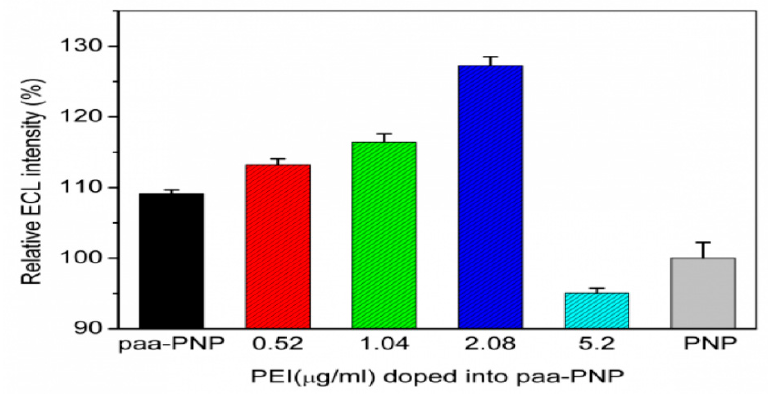
Figure 5. Effect of the doping amount of polymer poly-ethyleneimine (PEI) on the ECL intensity of the PAA-doped polymer nanoparticle paa–PNP.